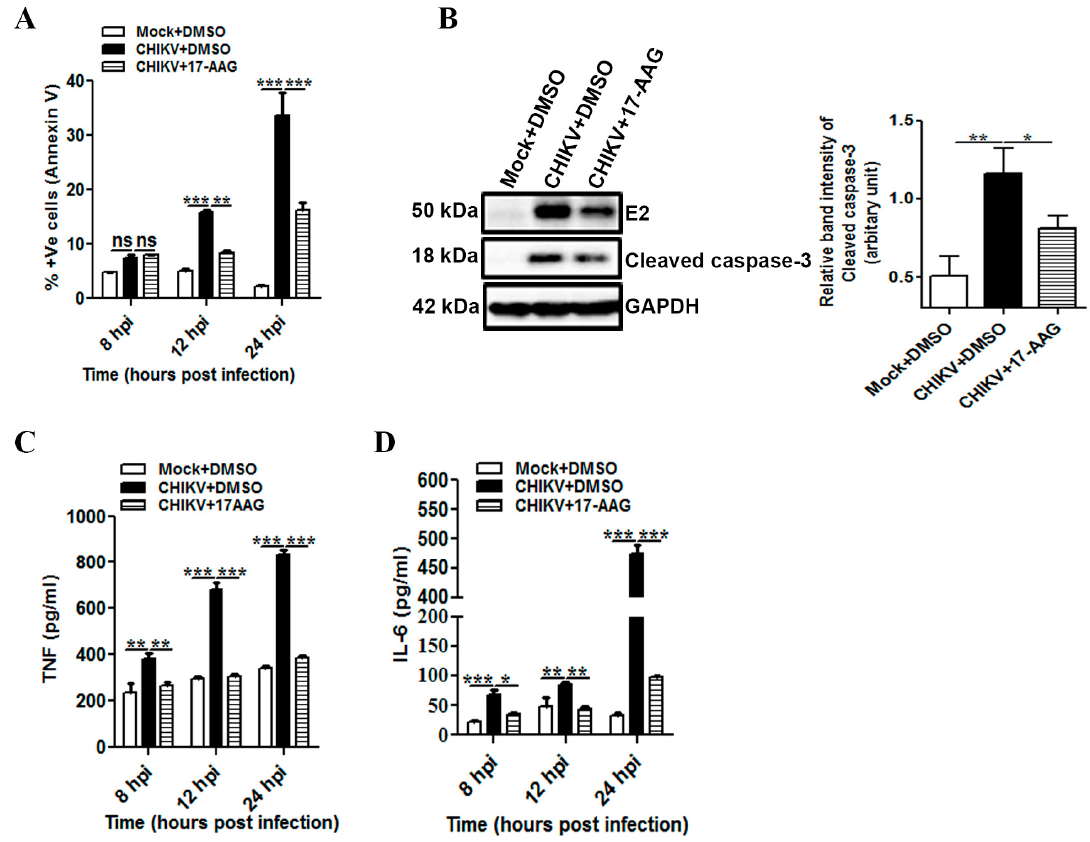
Figure 6. Suppression of CHIKV induced apoptosis and pro-inflammatory responses in macrophages by 17-AAG. Raw cells were infected with CHIKV at MOI 5. The cells were treated with either DMSO or 17-AAG as described earlier. ( A ) Percent Annexin V positive cells for mock + DMSO, CHIKV + DMSO and CHIKV + 17-AAG at 8, 12 and 24 hpi. ( B ) Western blot analysis showing the expression of the cleaved caspase-3, E2 and GAPDH in the presence of 17-AAG during CHIKV infection in macrophage at 12 hpi (left). Bar diagram showing relative band intensity of cleaved caspase-3 of mock + DMSO, CHIKV + DMSO and CHIKV + 17-AAG analyzed by the Quantity One 1-D analysis software (right). Cell culture supernatants were collected and were assessed for TNF ( C ) and IL-6 ( D ) secretion for mock + DMSO, CHIKV + DMSO and CHIKV + 17-AAG by sandwich ELISA at 8, 12 and 24 hpi. Data represent mean ± SEM of at least three independent experiments. p < 0.05 was considered as statistically significant difference between the groups. (ns, non-significant; * p < 0.05; ** p ≤ 0.01; *** p ≤